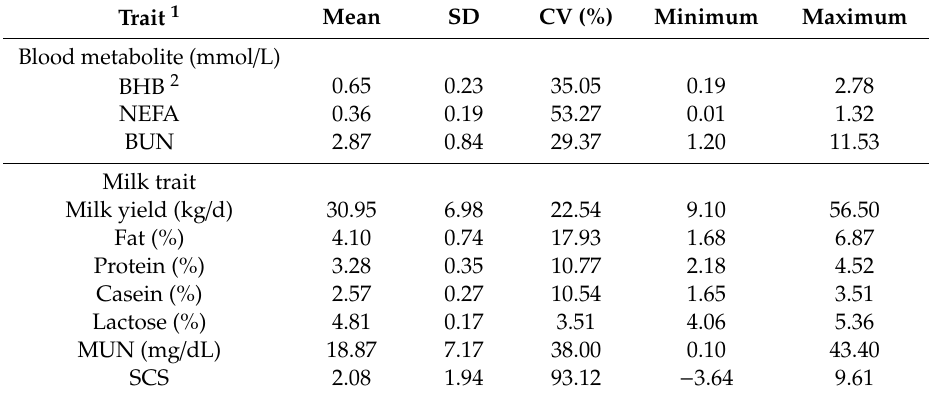
Table 2. Mean, standard deviation (SD), coe ffi cient of variation (CV), minimum, and maximum of predicted blood metabolites, milk yield, and composition traits of early-lactation cows in multi-breed herds (43,201